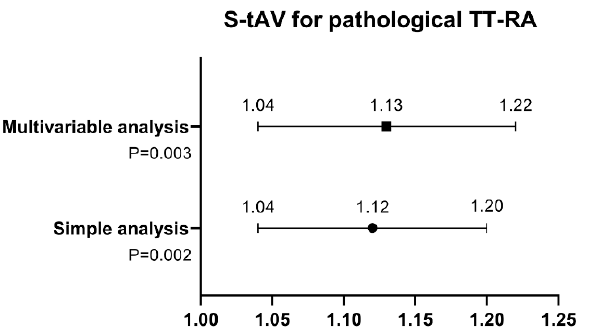
Figure 5. Receiver operating characteristic curve (ROC) of S-tAV ( A ) and P-tAV ( B ) for a pathological TT-RA distance. The areas under the curves (AUC) and the p values are shown.